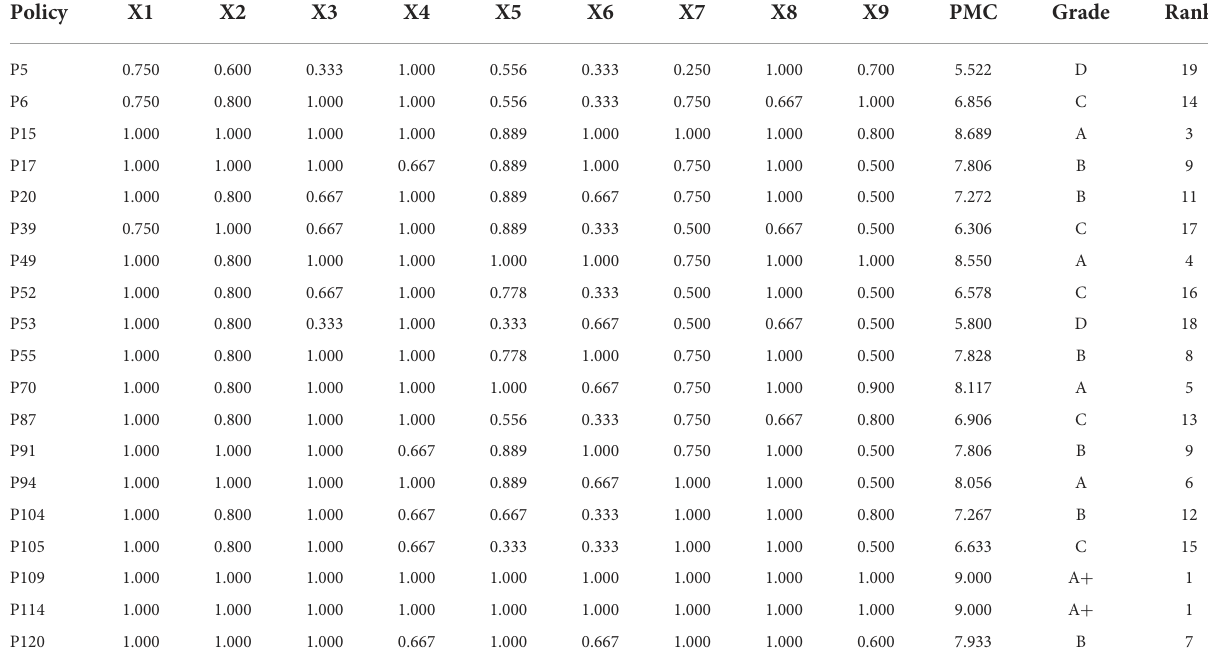
TABLE 4 The PMC index values and grades of selected